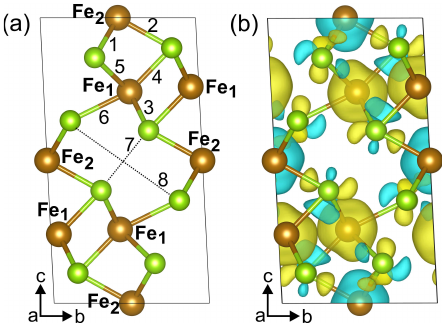
Figure 1. Atomic structure ( a ) and the spin-resolved magnetization density ( b ) of Fe 3 Se 4 . The unit cell is marked with black lines. Brown and yellow-green colors correspond to Fe and Se atoms, respectively. In panel ( b ), yellow (blue) areas indicate the spin-up (spin-down) density. Isosurface value is 0.002 a − 3 ,where a 0 is the Bohr 0